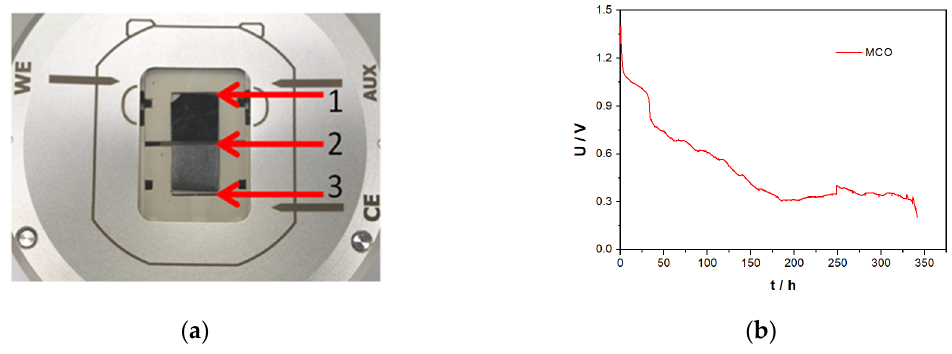
Figure 17. ( a ) SBS cell design (1:GDE, 2:separator, 3:Zn / carbon paper) and ( b ) Zn / air cell discharge profile in ChAcO + 30 wt.% H 2 O at 5 µA cm − 2 .